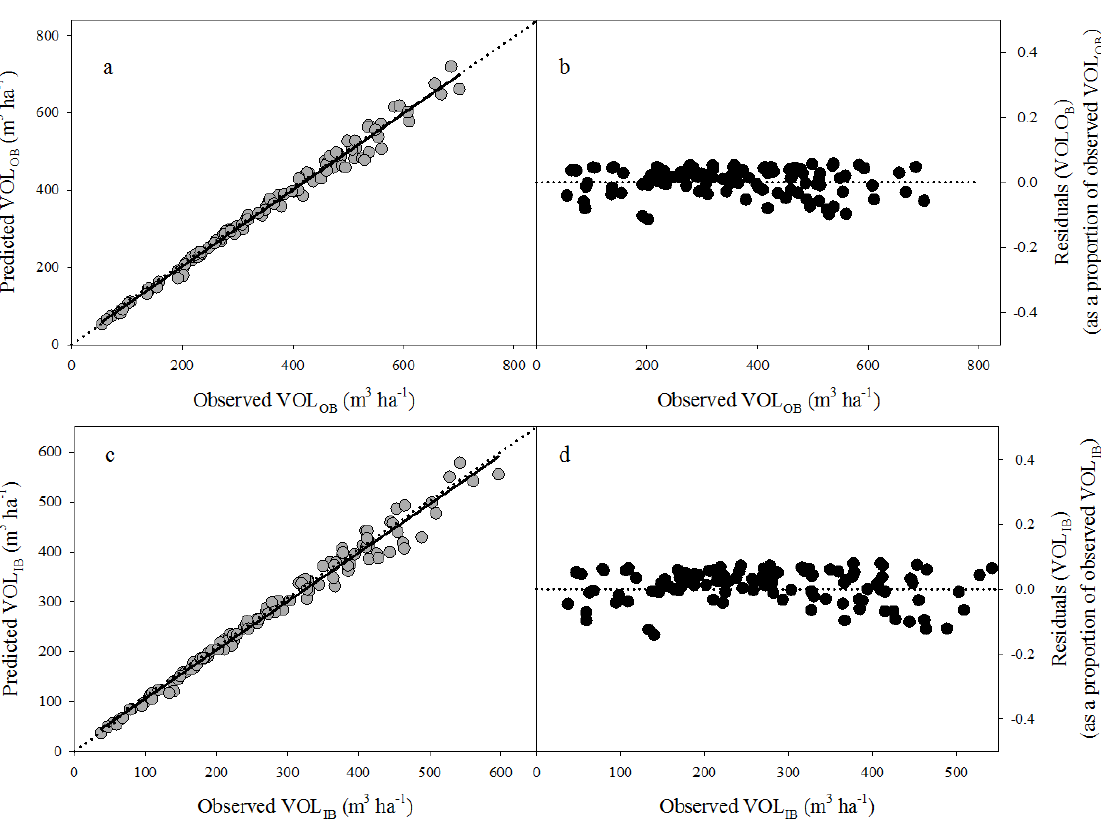
Figure 3. Validation of total stem volume outside (VOL ) ( a , b ) and inside (VOL ) ( c , d ) OB IB ) ( e , f ) and merchantable volume breakdown (VOL ) ( g to j ) bark, BA after thinning (BA t m models based on 30 pots from the model evaluation dataset. Observed versus predicted (simulated) values ( a , c , e , g , i ) and residuals (predicted-observed) versus observed (b) VOL (d), BA (f) and VOL ( h , j ). Two examples of VOL outside values of VOL OB IB t m m bark are shown: using d = 10.16 cm and t = 20.32 cm ( g , h ) and d = 20.32 cm and t = 30.48 cm ( i , j ). Solid line represents linear fit between observed and predicted values and dotted lines for plots a , c , e , g and i correspond to the 1-to-1 relationship. Residuals are presented as a proportion of observed